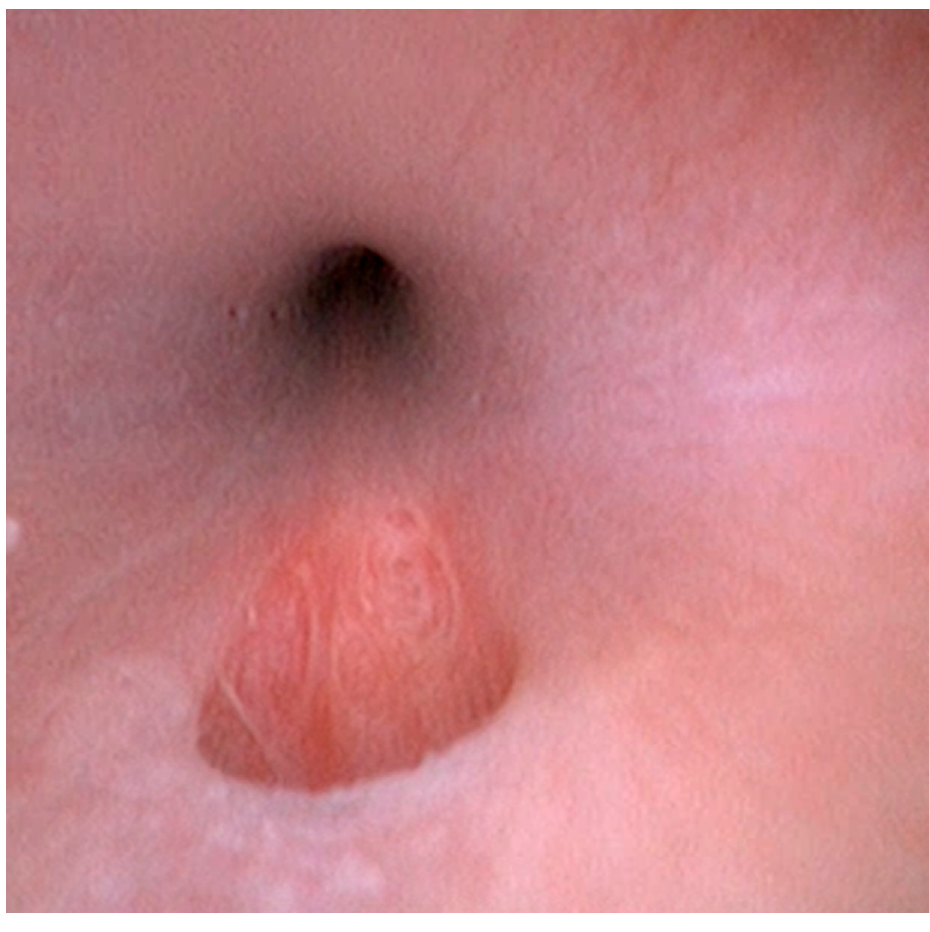
Figure 3. Cystoscopic image. The endoscopic examination revealing a hole (tear-shaped opening on the floor of the urethra).